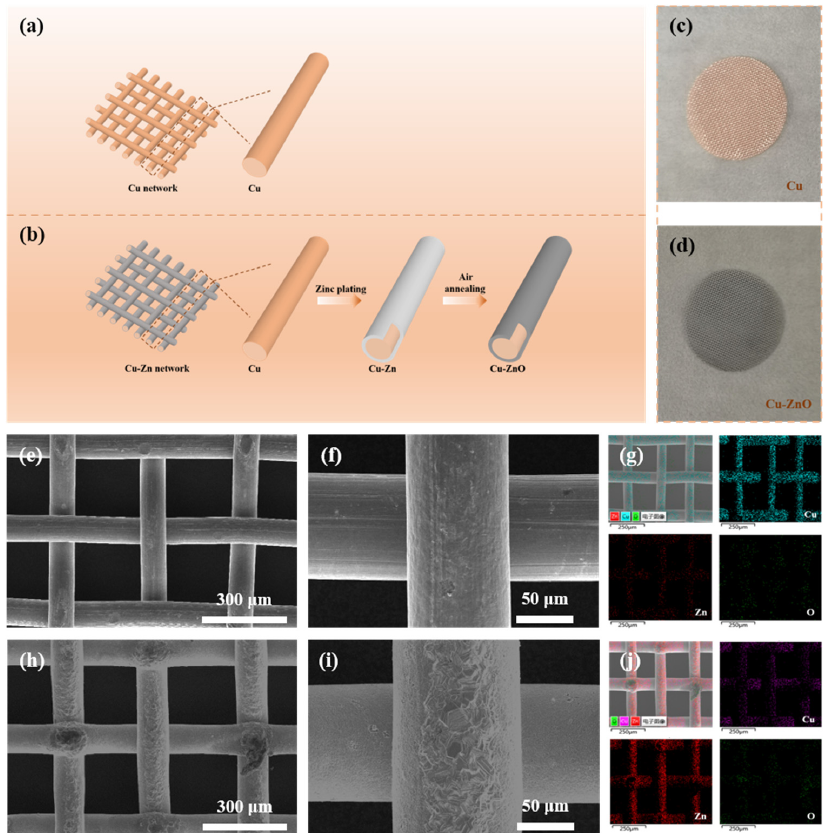
Figure 1. Schematic diagram of ( a ) commercial copper mesh and ( b ) fabrication of 3DM Cu/ZnO. Optical photograph of ( c ) 3DM Cu and ( d ) 3DM Cu/ZnO. SEM images of ( e , f ) 3DM Cu and ( h , i ) 3DM Cu/ZnO. EDS mapping of ( g ) 3DM Cu and ( j ) 3DM Cu/ZnO.